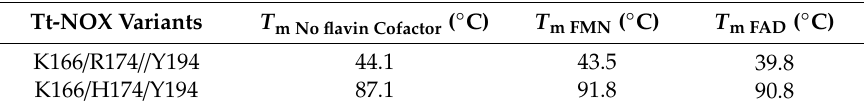
Table 1. Thermodynamic stability ( T m ) of the K166 / R174 / Y194 and K166 / H174 / Y194 variants in the presence and the absence of flavin